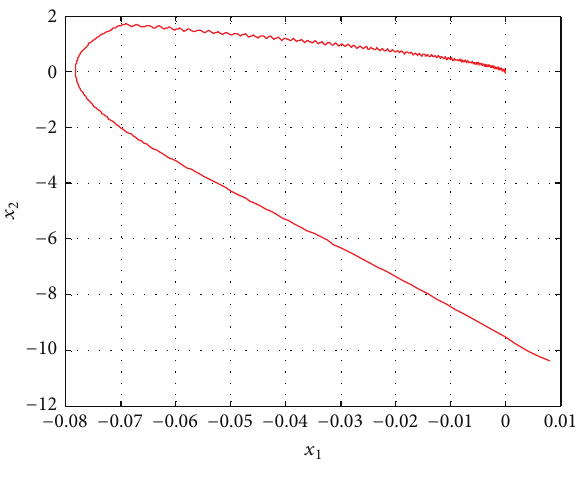
Figure 9: Control input ( 𝑢 ).